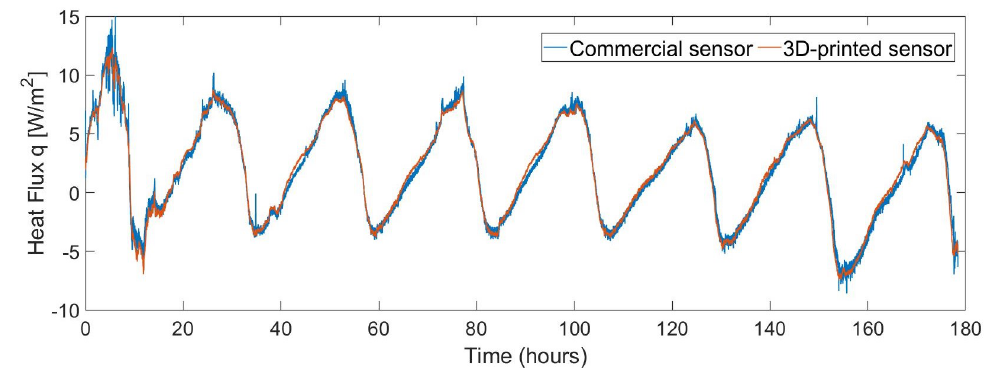
Figure 13. Comparison between the measurements of the commercial sensor and the 3D-printed sensor installed on a wall for eight days.